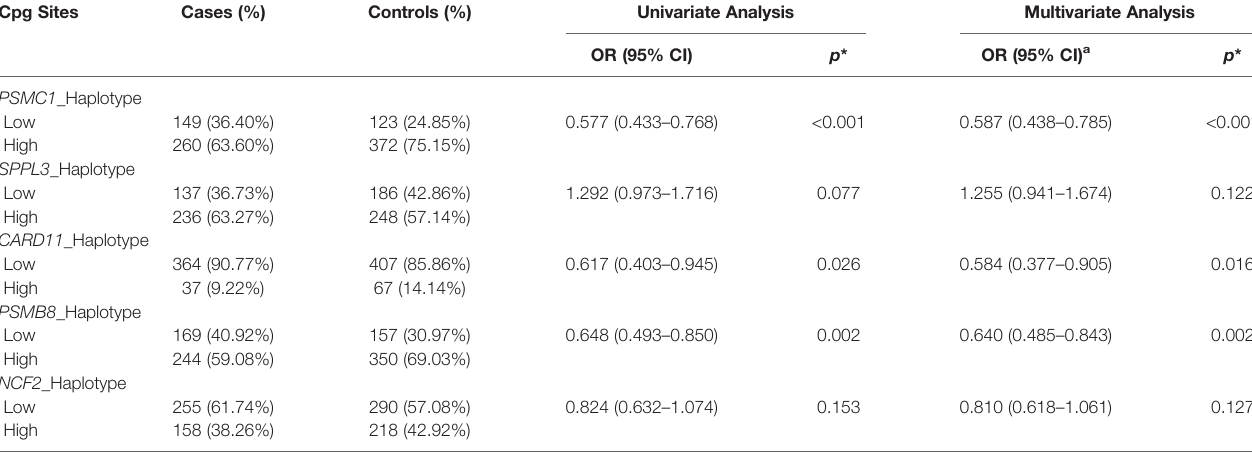
TABLE 5 | The association between methylation haplotype burden of fi ve genes and BC